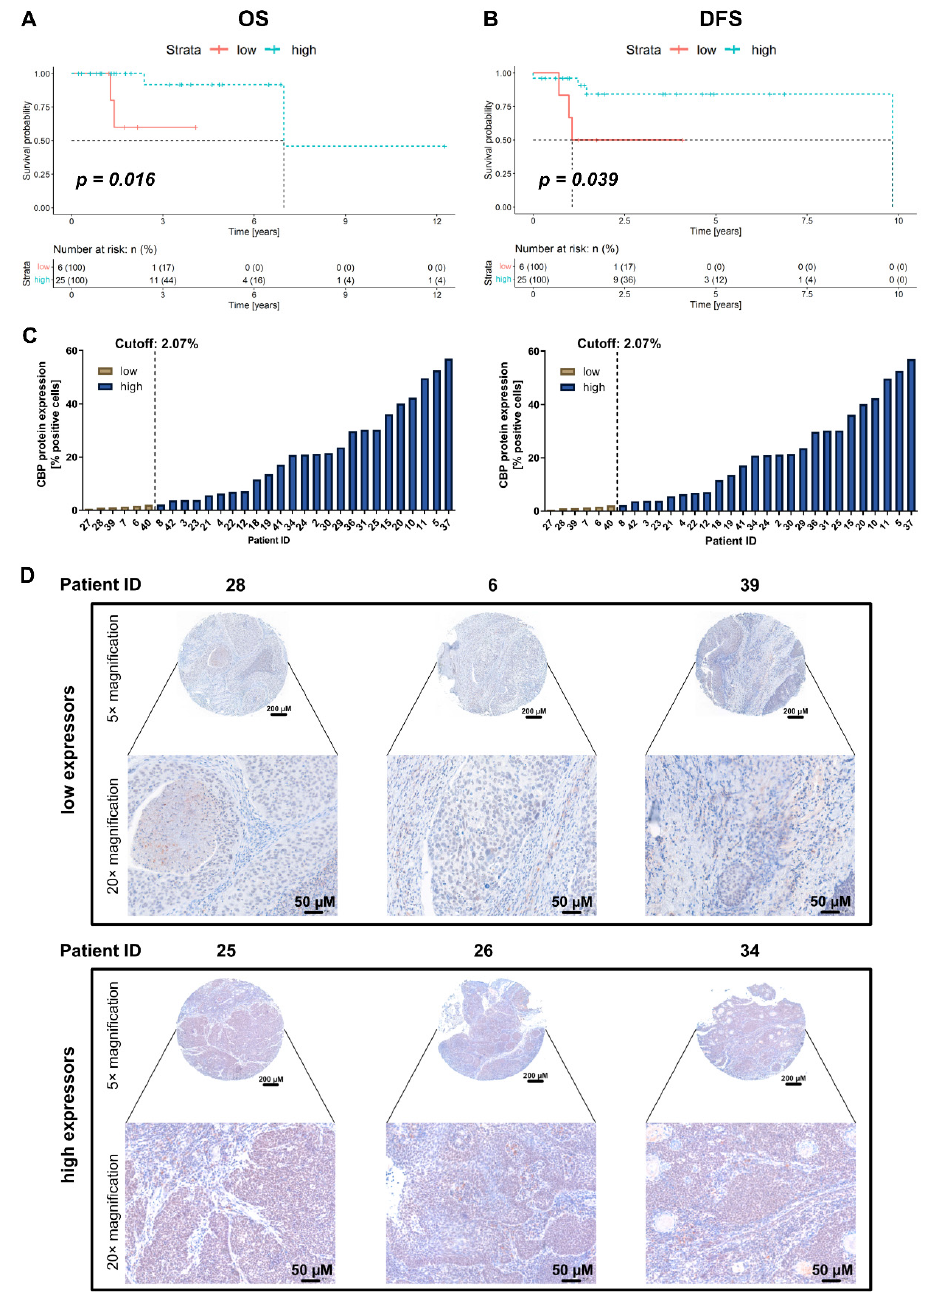
Figure 2. ( A ) Kaplan–Meier survival curve for OS stratified into a high and low group according to the OTV of the CBP expression. Significantly longer overall survival was observed in the group with high CBP protein expression ( p = 0.016). ( B ) Kaplan–Meier survival curve for DFS stratified into high and low group according to the OTV of the CBP expression. Significantly longer disease-free survival was observed in the group with high CBP protein expression ( p = 0.039). ( C ) Respective CPB expression values per patient stratified into the two groups (“low” [brown] and “high” [blue]) according to the OTV for OS ( left ) and DFS ( right ). ( D ) Representative images from the IHC staining for CBP, stratified into “low expressors” ( top ) and “high expressors” ( bottom ) according to the OTV. OS; overall survival, DFS; disease-free survival, CBP; Creb-binding protein, OTV; optimized threshold value, IHC; immunohistochemistry staining, µ m; micrometer, low; the group with low CBP expression according to the OTV, high; the group with high CBP expression according to the